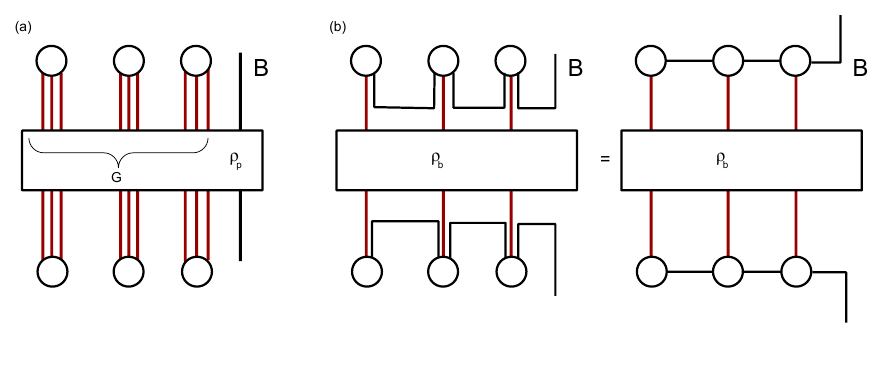
Figure 13. Illustration of (a) a most general random tensor network state de(cid:12)ned in eq. (4.1); (b) an \ordinary" random tensor network state in which (cid:26) P has the tensor factorization structure